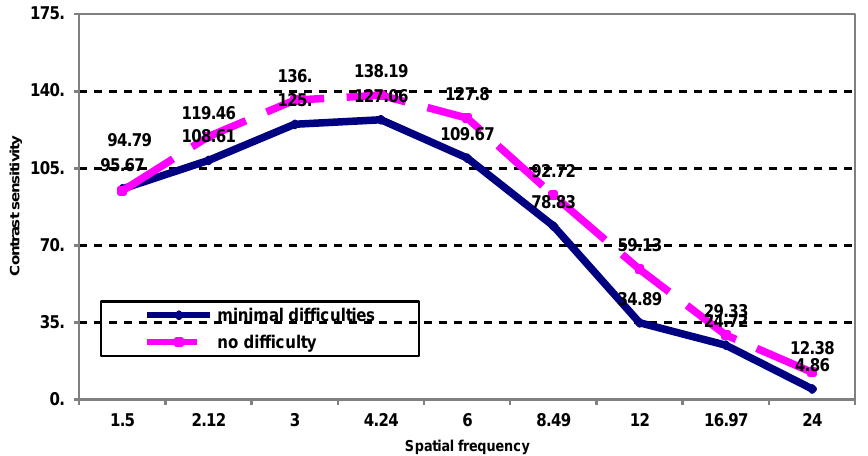
Figure 1. The contrast sensitivity as a function of spatial frequency in patients who have minimal post-treatment visual difficulties recognizing a person.